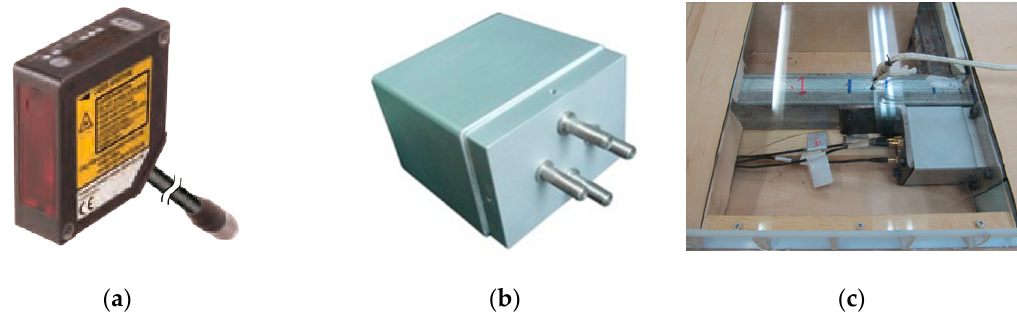
Figure 18. The dynamic sensors used in the measurement. ( a ) Laser displacement sensor; ( b ) force balance; ( c ) installation inside the sectional model.